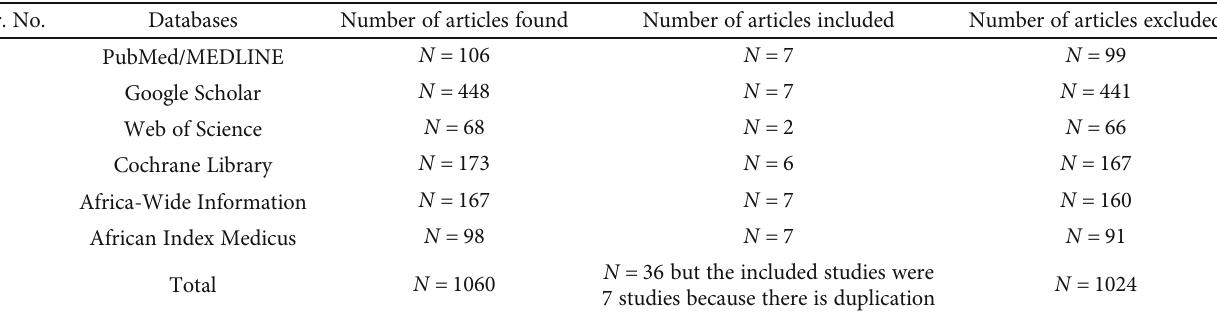
Figure 1: Flow chart diagram showing the selection of articles for systematic review and meta-analysis of burnout among nurses in Ethiopia 2020. Table 1: Search terms and strategy for burnout among nurses in